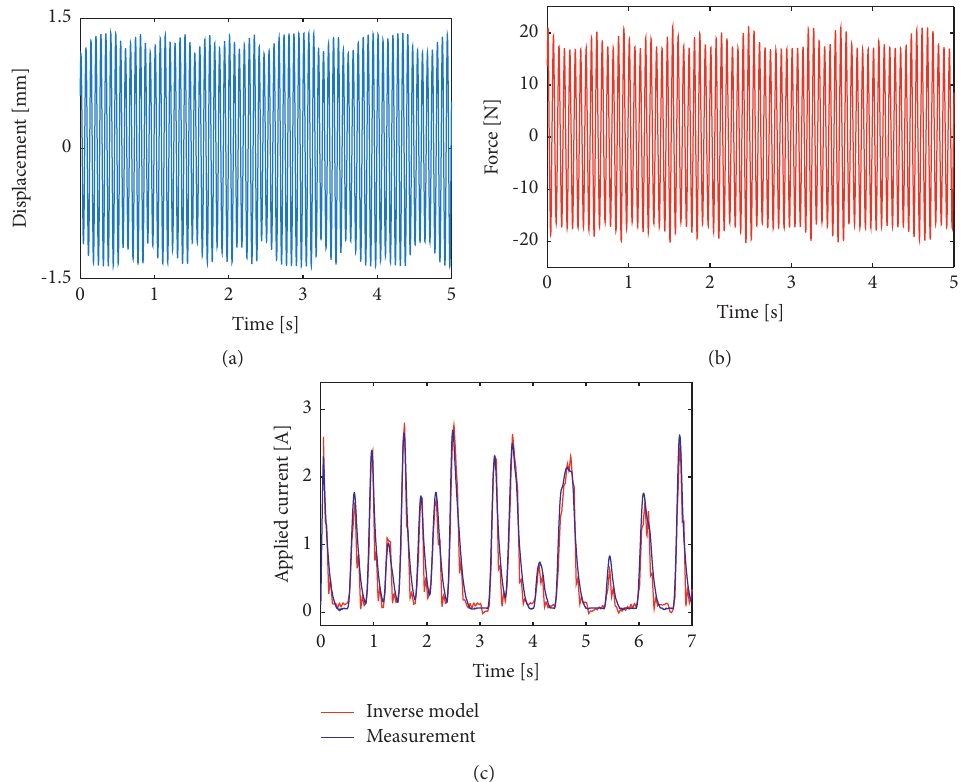
Figure 6: Applied current response using MRE inverse model: (a) displacement data, (b) force data, and (c) applied current response.